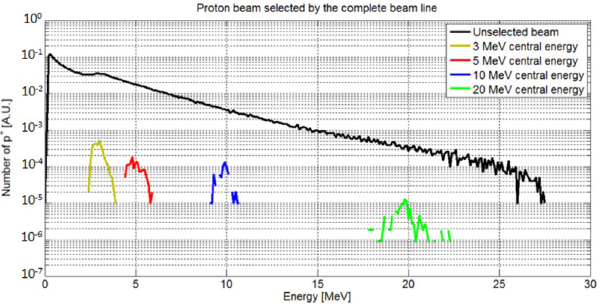
Figure 6. Final energy spread of the proton beam as obtained at the end of the complete beamline, including the focusing PMQ array and the ES. The focusing section has been optimized differently for each central energy. The parameters of the ES, indicated in Table 1, are the same for all energies in the range 2–20 MeV and have η ≥ (for all analyzed been optimized using the data reported in Fig. 2. The obtained efficiency 1% BL